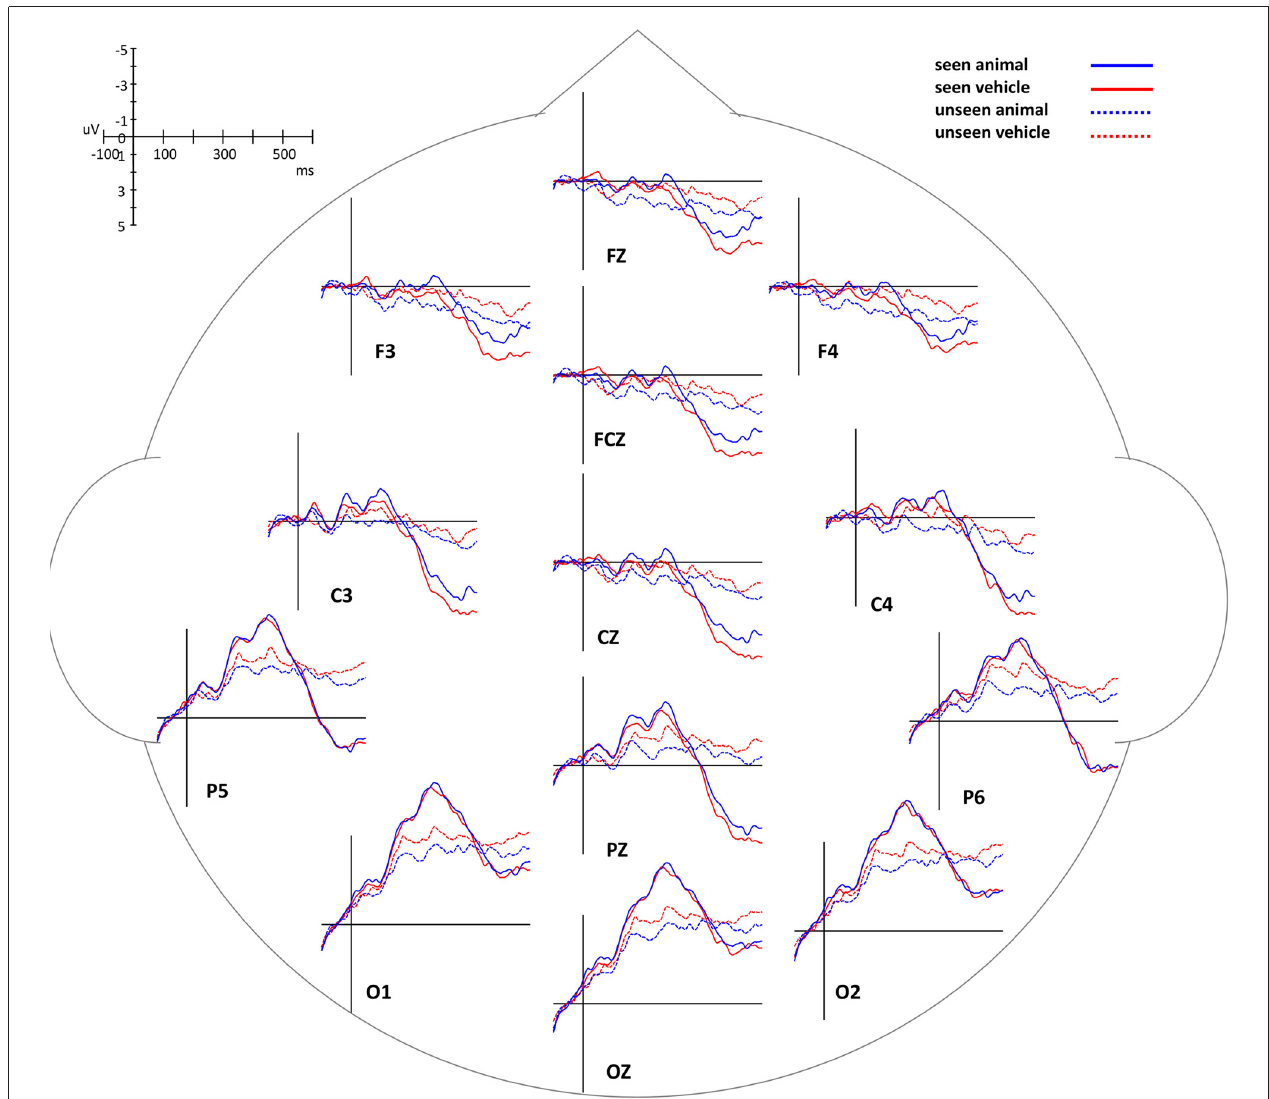
FIGURE 7 | ERP waveforms of animal and vehicle stimuli in seen and unseen trials, aligned to stimulus